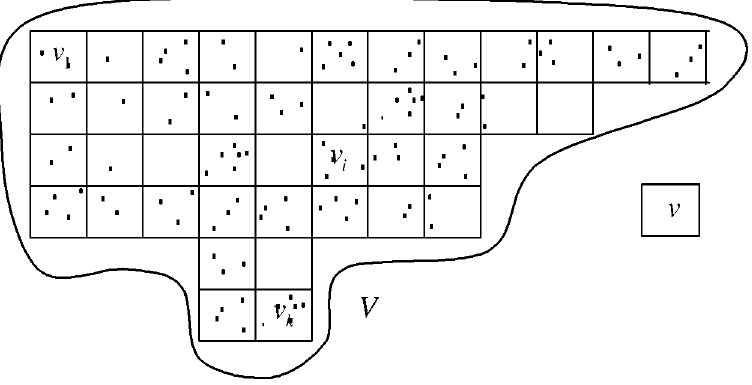
Fig. 2. Example of a two-dimensional histological tumour sample, with contiguous partitioning of domain V into sub-domains v 1 , ::: , v k . statistics [12,29] and dispersion variance, which stems from